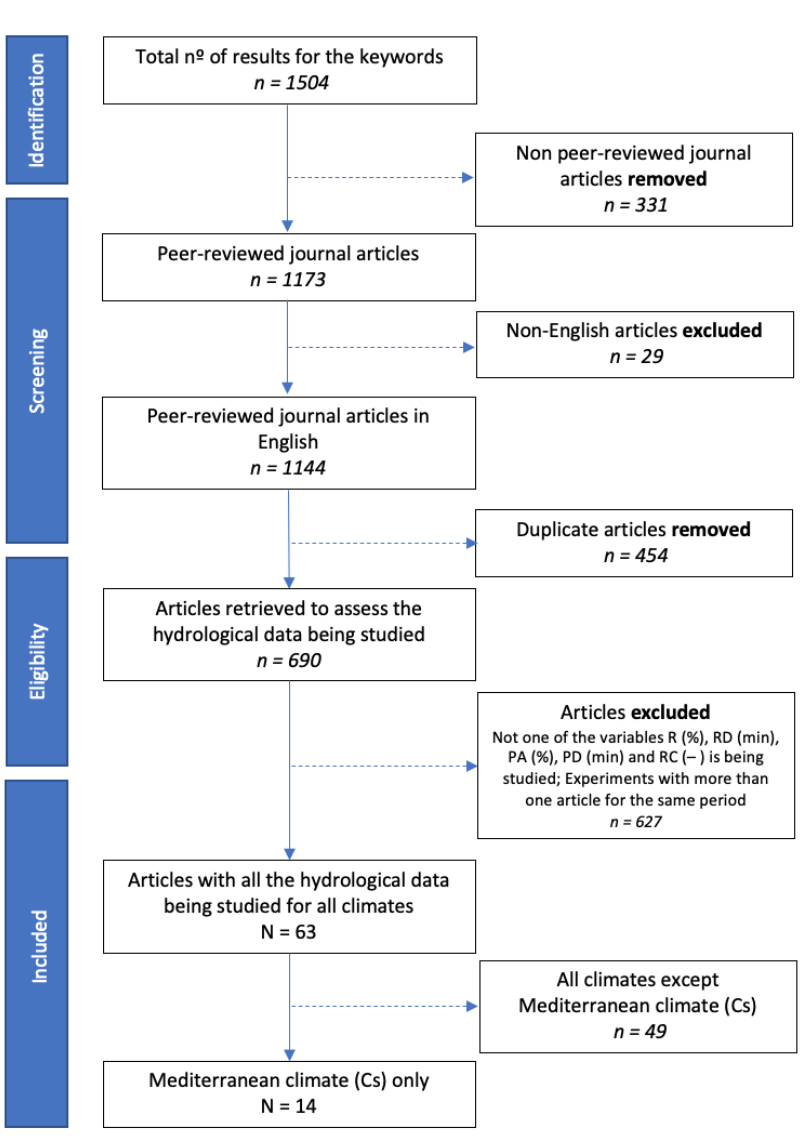
Figure 1. Flowchart of article selection process using the research tool Web of Science.